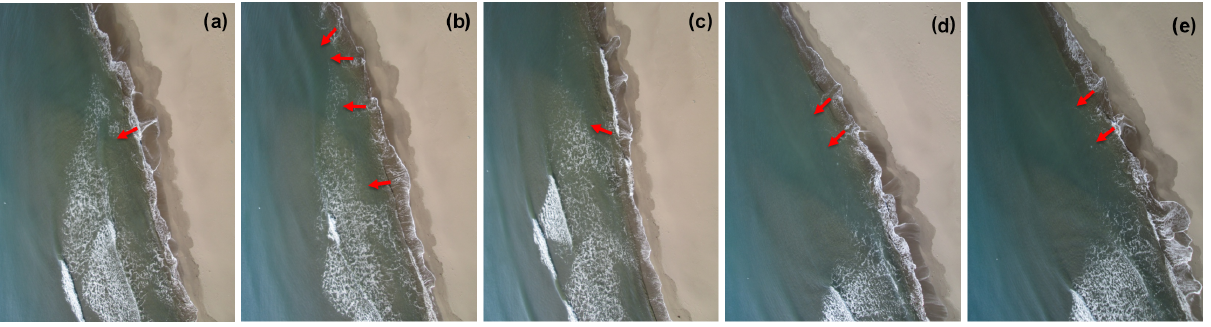
Figure 7. Evidence of rip currents during RPAS acquisition in individual images captured on 21 January 2017. The red arrows are represen- tative of the rip